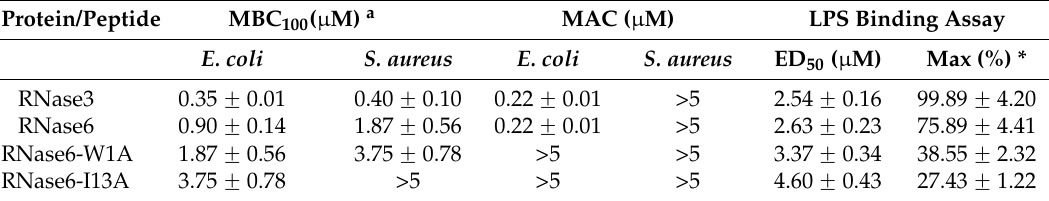
Table 8. MBC, MAC and LPS Binding activities of RNase3, RNase6 and RNase6 mutants.